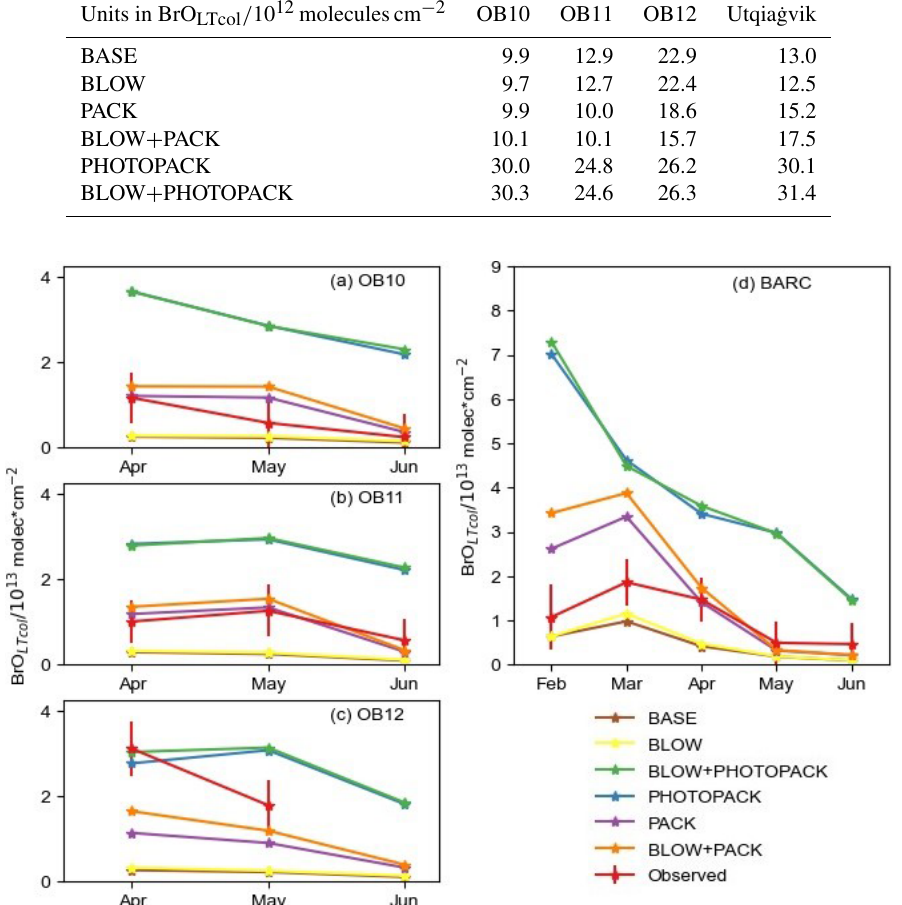
Figure 5. Monthly average BrO LTcol in the observations and model. Monthly averages of BrO at (a) O-Buoy 10, (b) O-Buoy 11, (c) O-Buoy 12, and (d) BARC at Utqia˙gvik only using predictions and observations when dSCDO 4 > 1 × 10 43 molecules 2 cm − 5 . Observations with average 1 σ error shown in red. All units in 10 13 moleculescm − 2